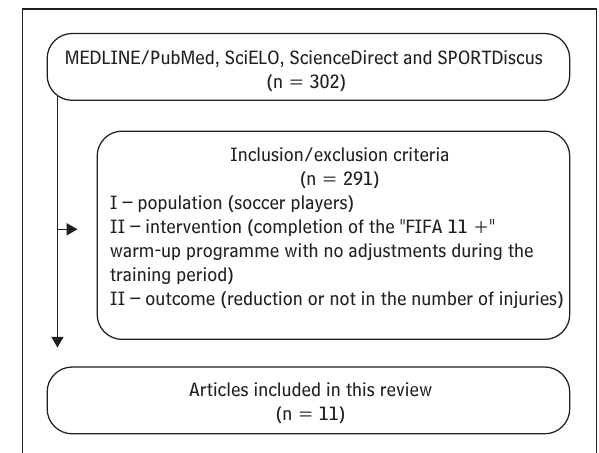
Figure 1 - Flowchart of the articles selection process